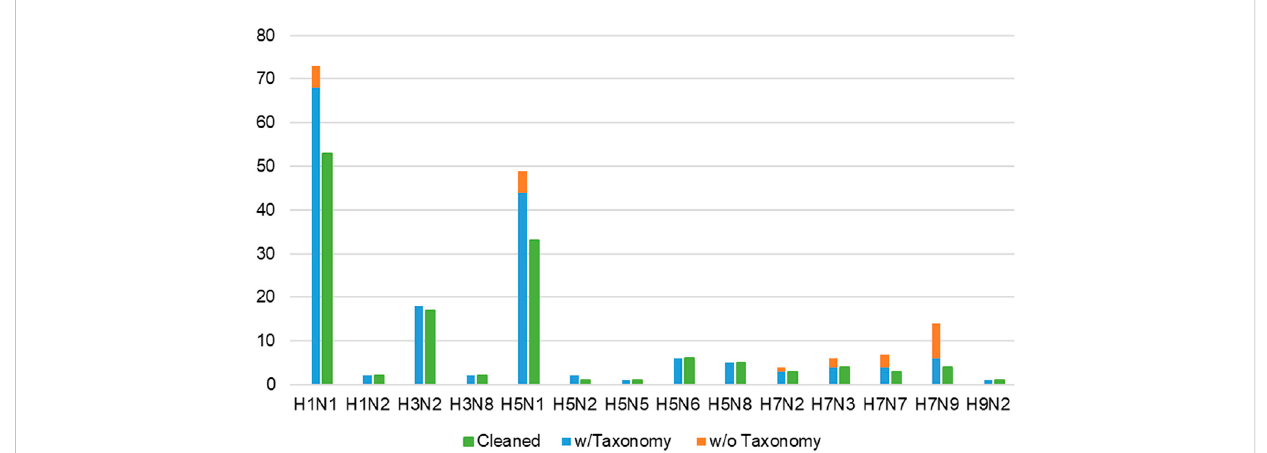
FIGURE 4 Proportion of all wild-type/laboratory IAV strains, separated into with and without taxonomy ID numbers, against remaining records (green bars) in the cleaned dataset. Infection records involving wild-type IAV where taxonomy ID number could not be found (orange bars) were omitted, reducing the number of infection records to 166 (blue bars). “ Cleaned ” refers to the fi nal dataset of 139 infection records (green bars) available in IAV-Mouse PPI database, where each record corresponds to a unique combination of IAV and mouse strain.